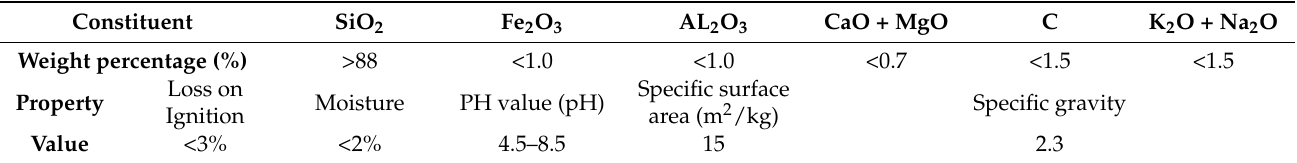
Table 1. Microsilica composition.